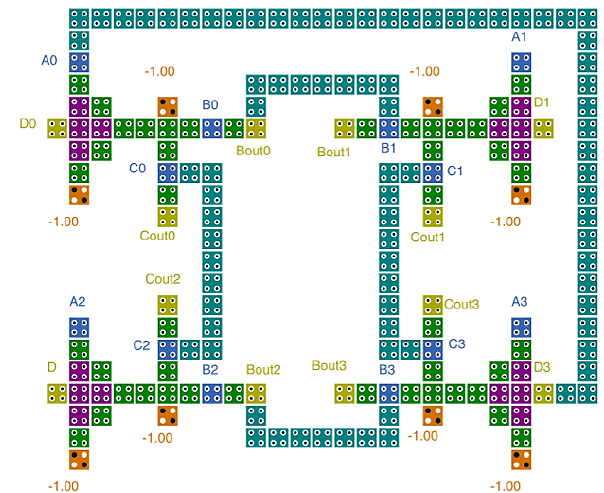
Figure 10. Design the proposed 𝟐 × 𝟐 Galois Field Matrix